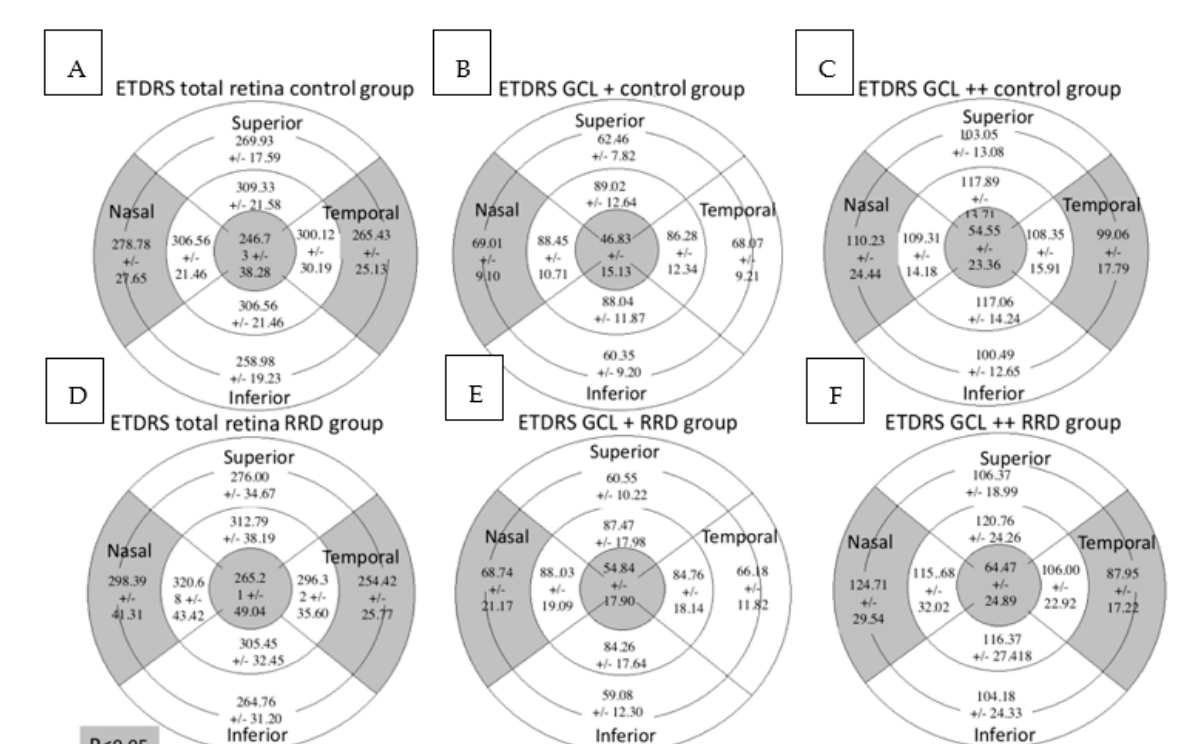
Figure 4. Macular parameters assessed by SS-OCT in both groups. Figures ( A – C ) represent control group outcomes while figures ( D – F ) represent RRD group outcomes. On top of each figure it is specified the SS-OCT protocol used. Total retinal thickness, GCL+ protocol and GCL++ protocol values are expressed in microns. Mean +/- standard deviation is included in every sector. Significant differences between the groups ( p < 0.05) are presented in gray background. SS-OCT: swept source optical coherence tomography; MAIA: macular integrity assessment; ETDRS: Early Treatment Diabetic Retinopathy Study; RRD: rhegmatogenous retinal detachment; GCL: ganglion cell layer. Table 2. Spearman correlations between functional data measured by MAIA in different sectors and anatomic data measured by SS-OCT in the 4 sectors the inner ring according to the total retina protocol, GCL+ protocol and GCL++ protocol. Significant correlations ( p < 0.05) are highlighted in bold print. ETDRS ETDRS ETDRS ETDRS GCL+ GCL+ SI TI II NI SI TI Correlation − MP coefficient SO